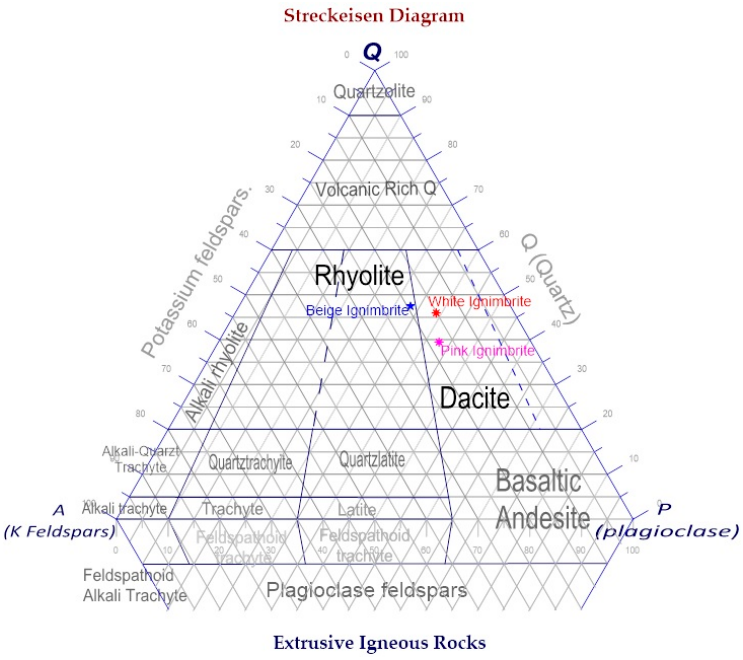
Figure 5. Classification of ignimbrites and their identifying field based on the percentages of min- eralogical phases found (ternary diagram QAPF). Table 2. Results from chemical analysis for the main elements.